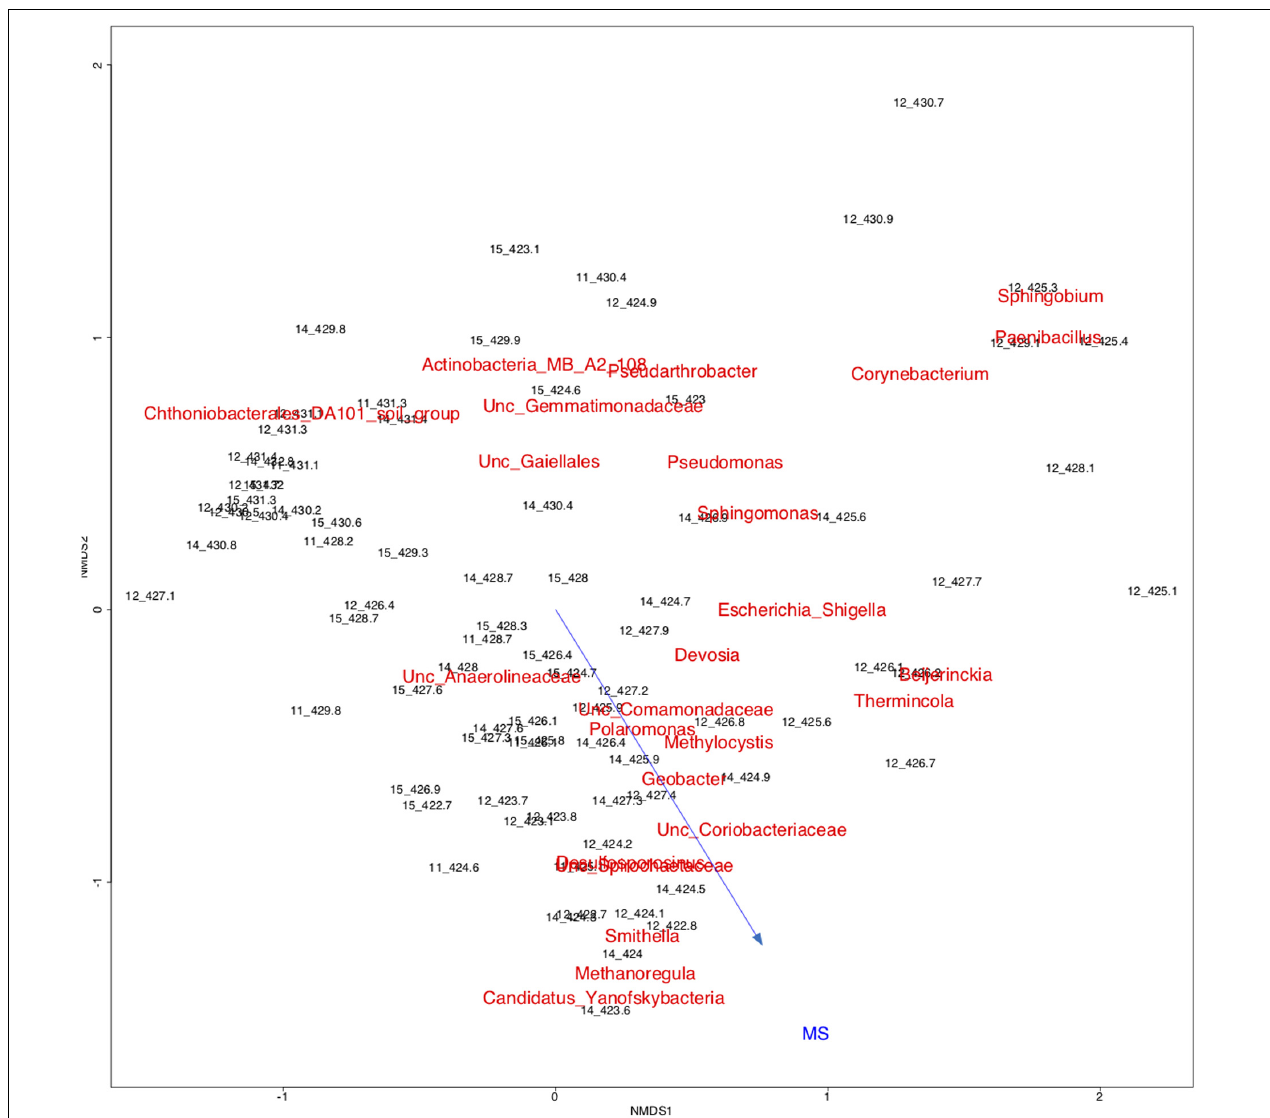
FIGURE 6 | Two-dimensional non-metric multidimensional scaling (NMDS) based on Bray-Curtis dissimilarities showing all samples from the complete lengths of cores collected in 2011, 2012, 2014, and 2015 from the free-phase oil zone, in addition to the top 25 microbial taxa and the magnetic susceptibility (MS) as variable (vector). Samples labeled according to the depths they were collected from are shown in black, while the microbial taxa are shown in red. The names for the two taxa “ Desulfosporosinus ” and “Unc. (= uncultured) Spirochaetaceae ” overlap. The MS arrow (blue) points into the direction of the samples and taxa from the free-phase oil, showing a correlation between theses samples, microbial taxa and the MS as environmental variable, although with low statistical significance ( p = 0.48). Plot Stress = 0.18.